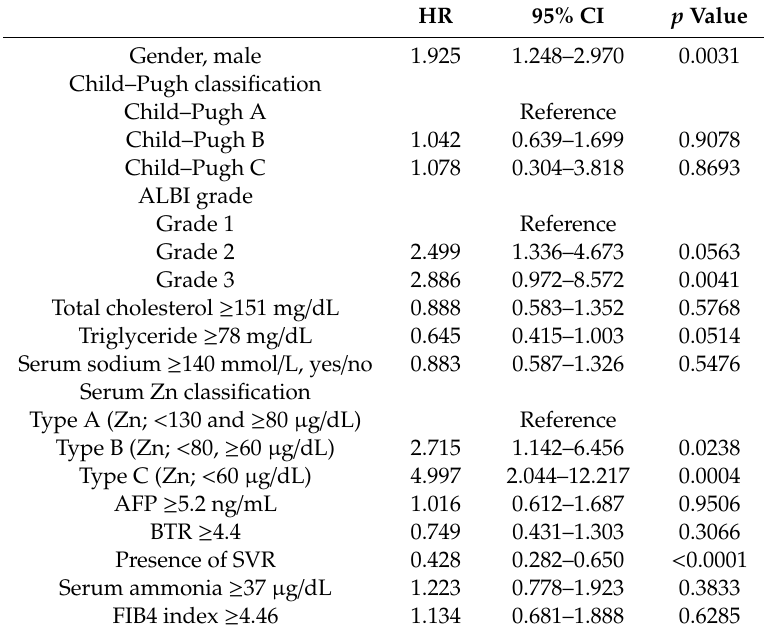
Table 4. Multivariate analyses of factors linked to the incidence of